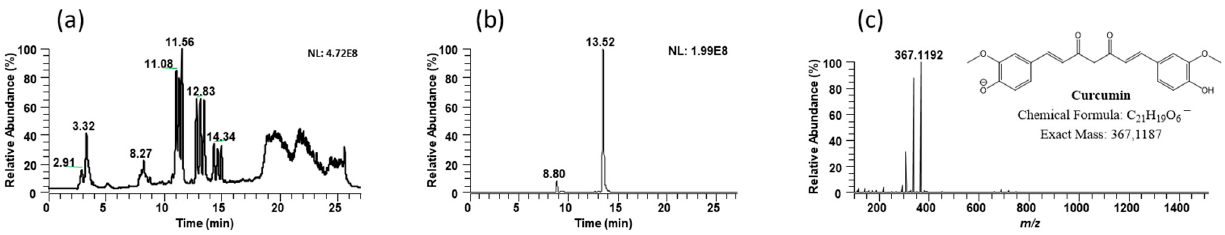
Figure 5. Reversed-phase liquid chromatography coupled to high-resolution mass spectrometry (LC-HRMS) total ion chromatogram ( a ) and extracted ion chromatogram of curcumin ( m/z 367.1187) ( b ). MS spectrum of peak at retention time of 13.52 min ( c ). Adapted from reference [82].